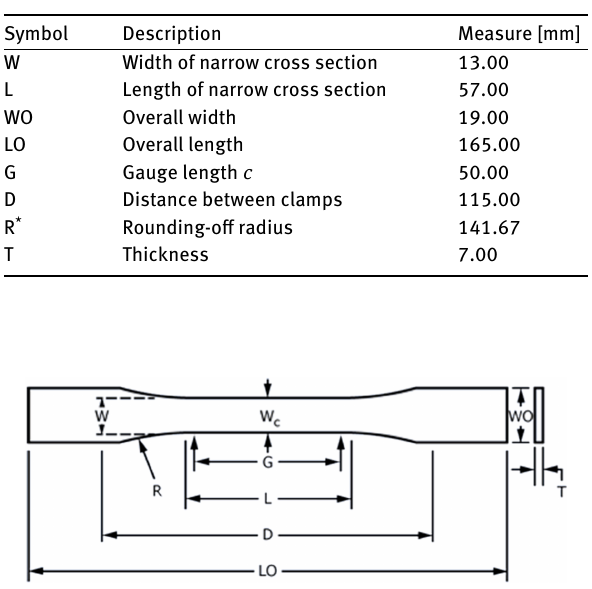
Figure 2: ASTM-D638, type I: dimensions [17]